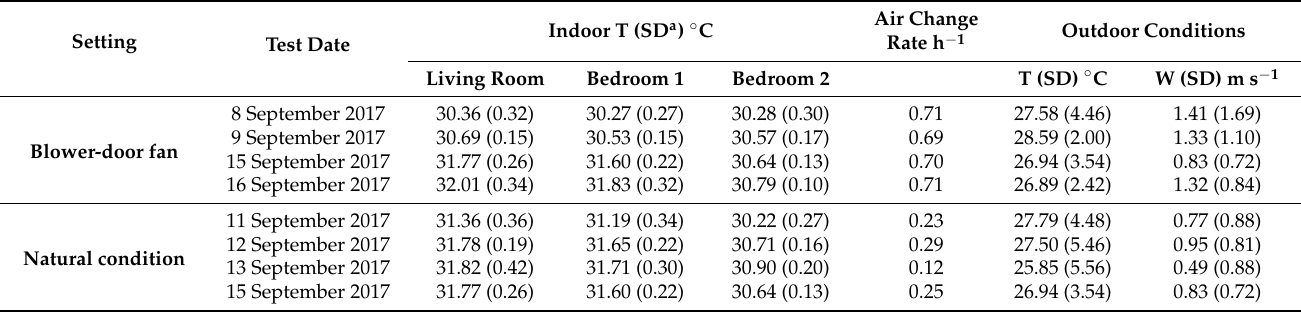
Table 1. Test information: setting; average indoor and outdoor temperature; overall air change rate; wind speed. Note: SD is the standard deviation.